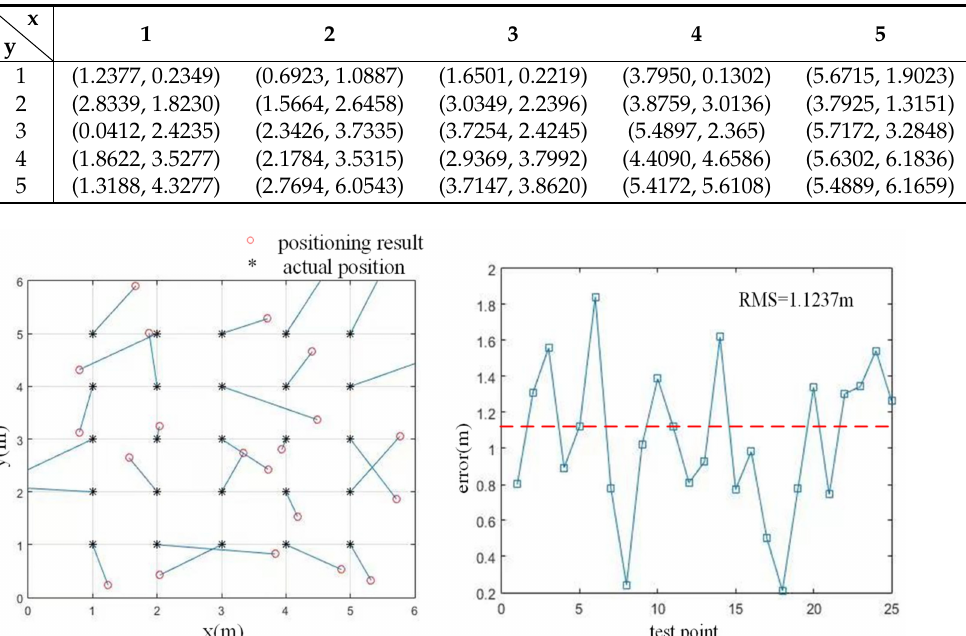
Table 4. Positioning results of uncollected fingerprint area.